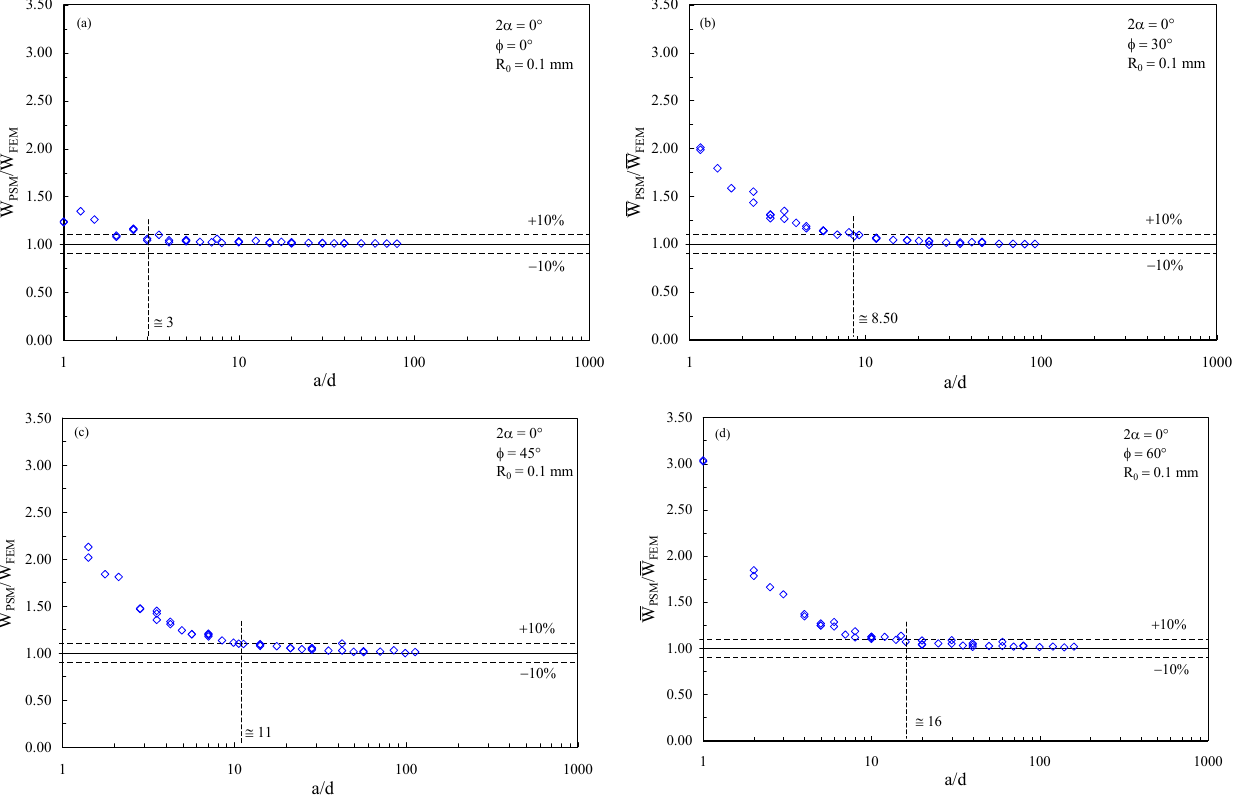
W ) and the SED derived from the FE analyses ( PSM